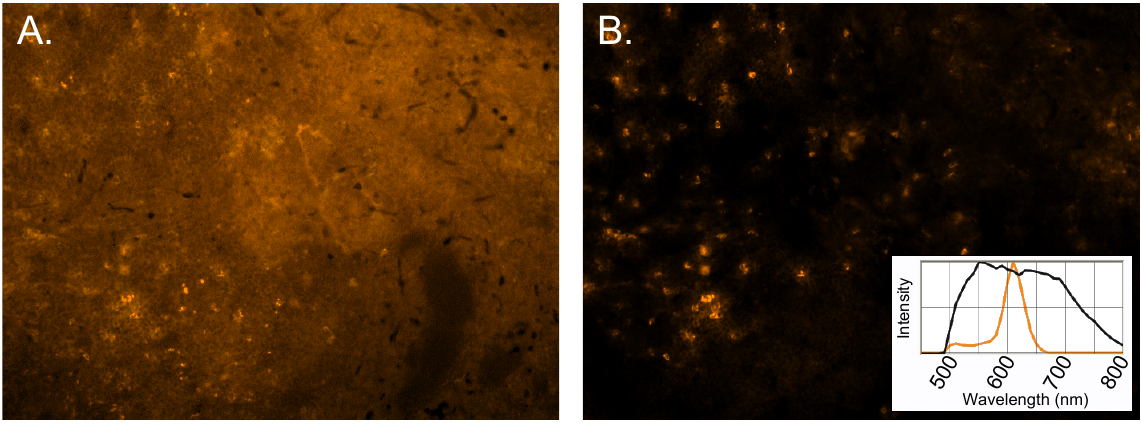
Figure 2. Autofluorescence subtraction for 605NC-CD11b stained mouse spleen. ( A )